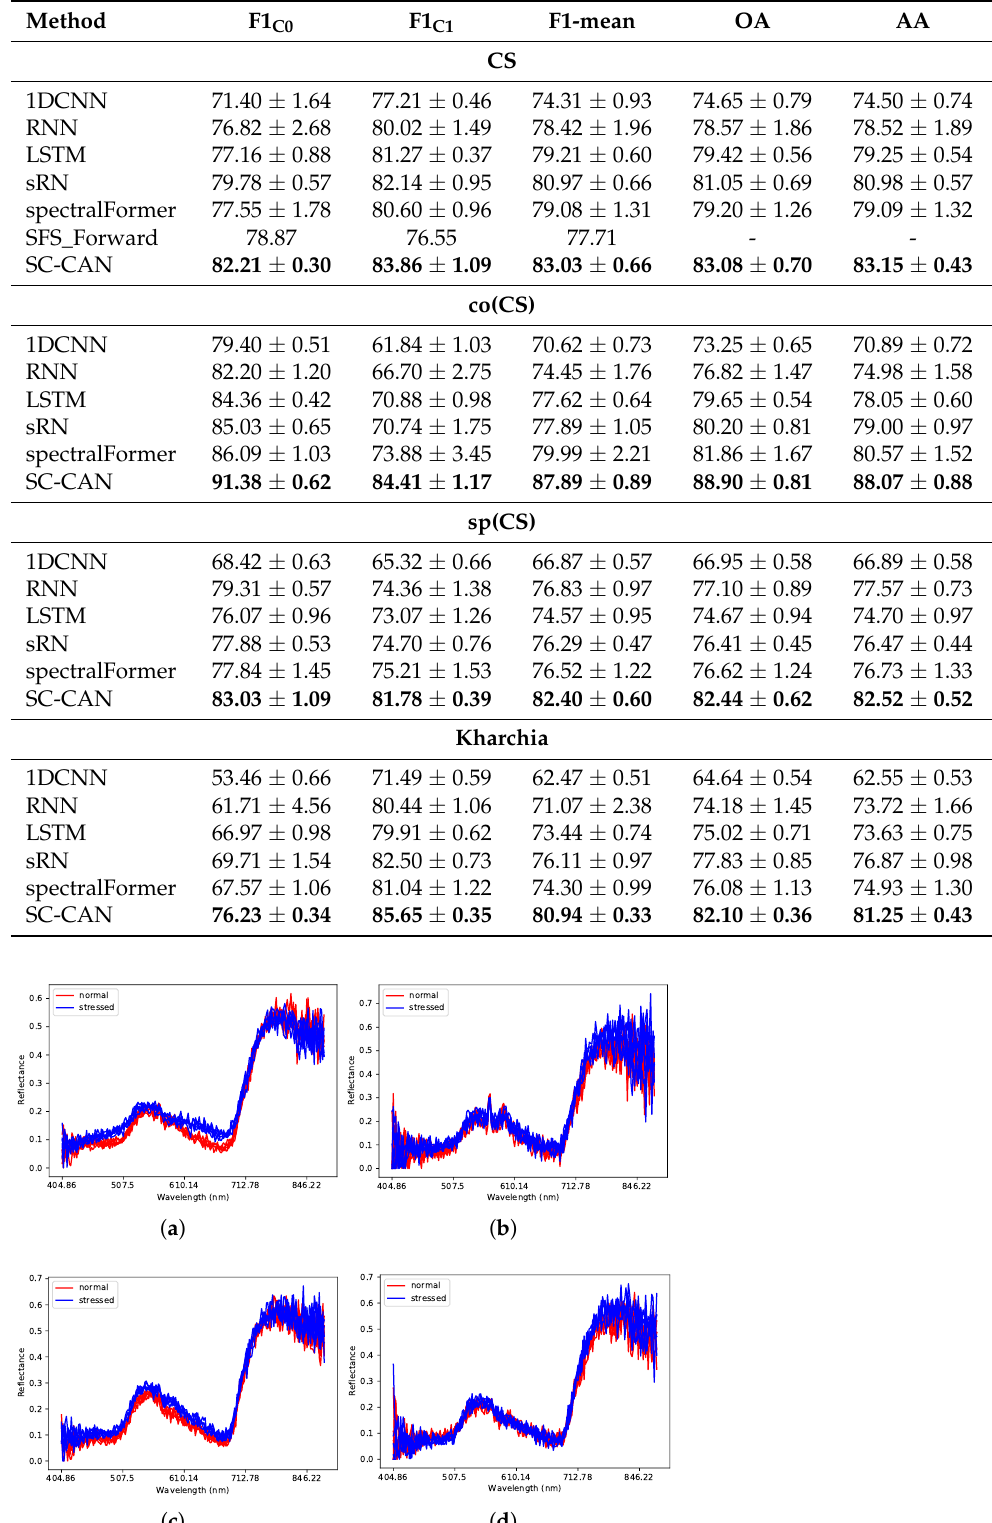
Table 2. Performance comparison between our proposed method and existing methods with CS, co(CS), sp(CS), and Kharchia datasets. The numbers in bold show the best performance.